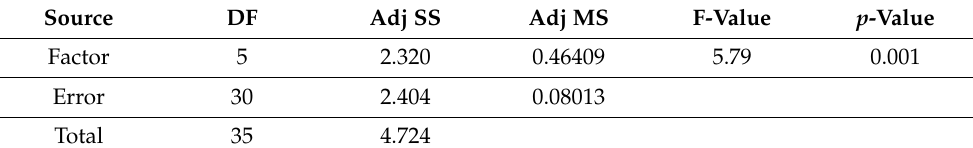
Table 5. ANOVA of the flexural modulus hybrid jute–ramie reinforced